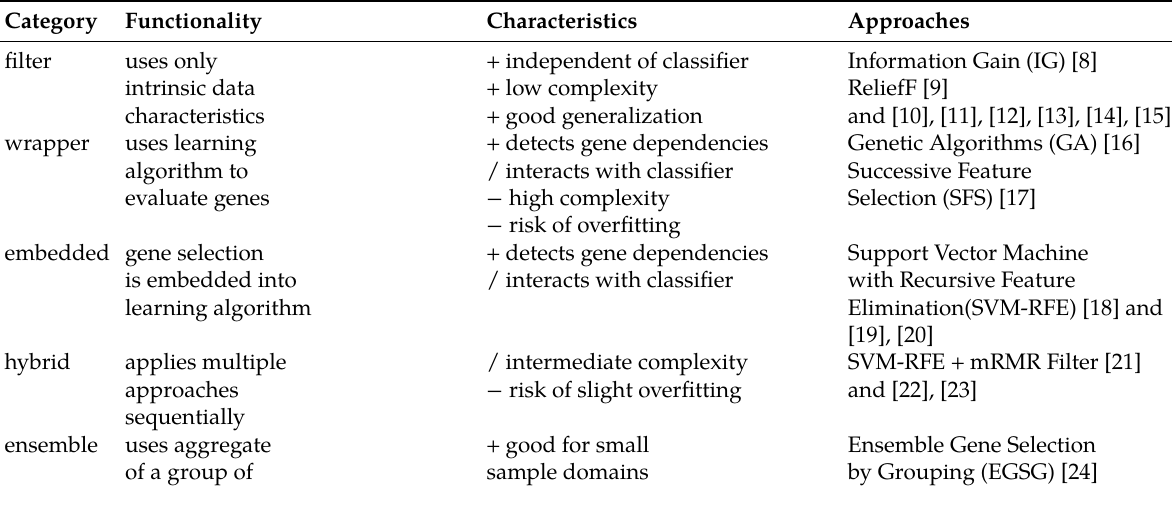
Table 1: Overview on traditional gene selection approaches and their classification. Filter approaches have lowest com- plexity, wrapper and embedded approaches apply machine learning strategies, hybrid and ensemble approaches com- bine multiple